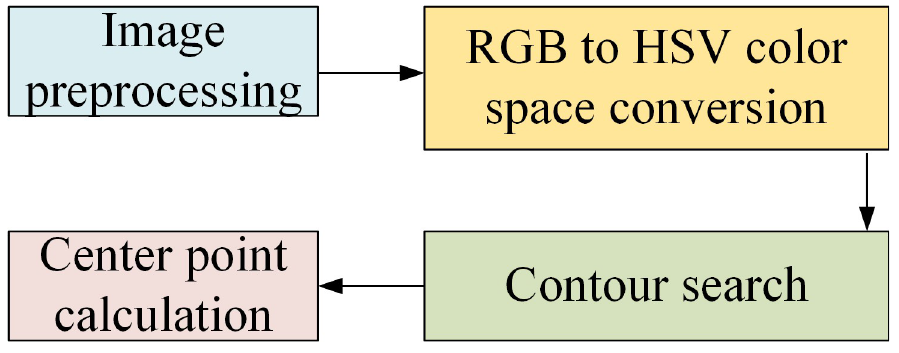
Fig 1. A demonstration of traditional recognition and detection algorithms of table tennis.